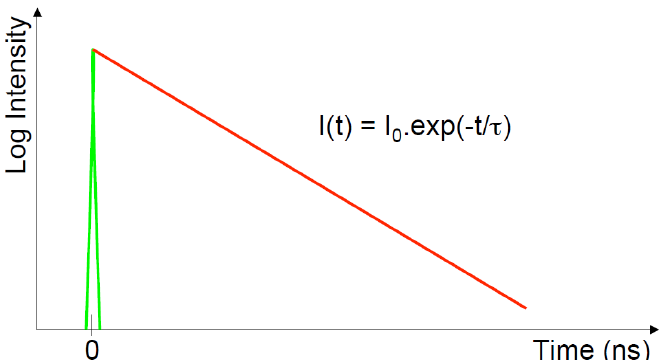
Figure 1. In the time domain, fluorescence intensity decay is measured directly as a function of